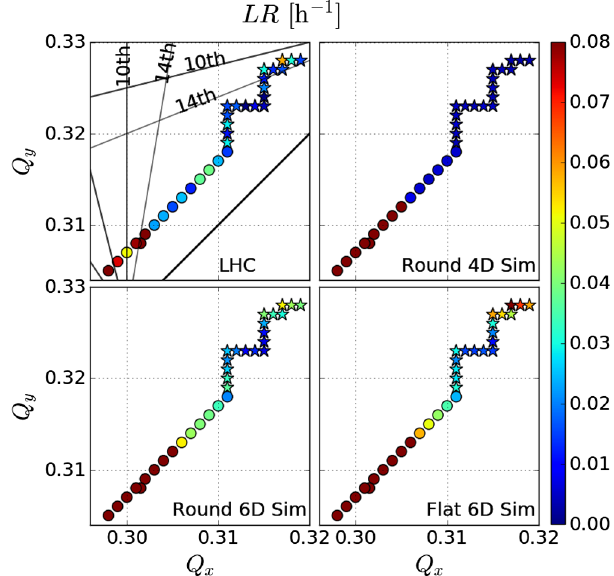
FIG. 23. Loss rates measured in the LHC, subtracted the estimated luminosity burn-off of 5% h − 1 , and loss rates ( LR ) calculated by CABIN for the same configurations using Beam the different implementations of the beam-beam interaction. The circles and stars correspond to the first and second fill respec- tively. Even resonance lines up to 14th order are plotted on top of the LHC measurements, with width proportional to the strength of the resonance